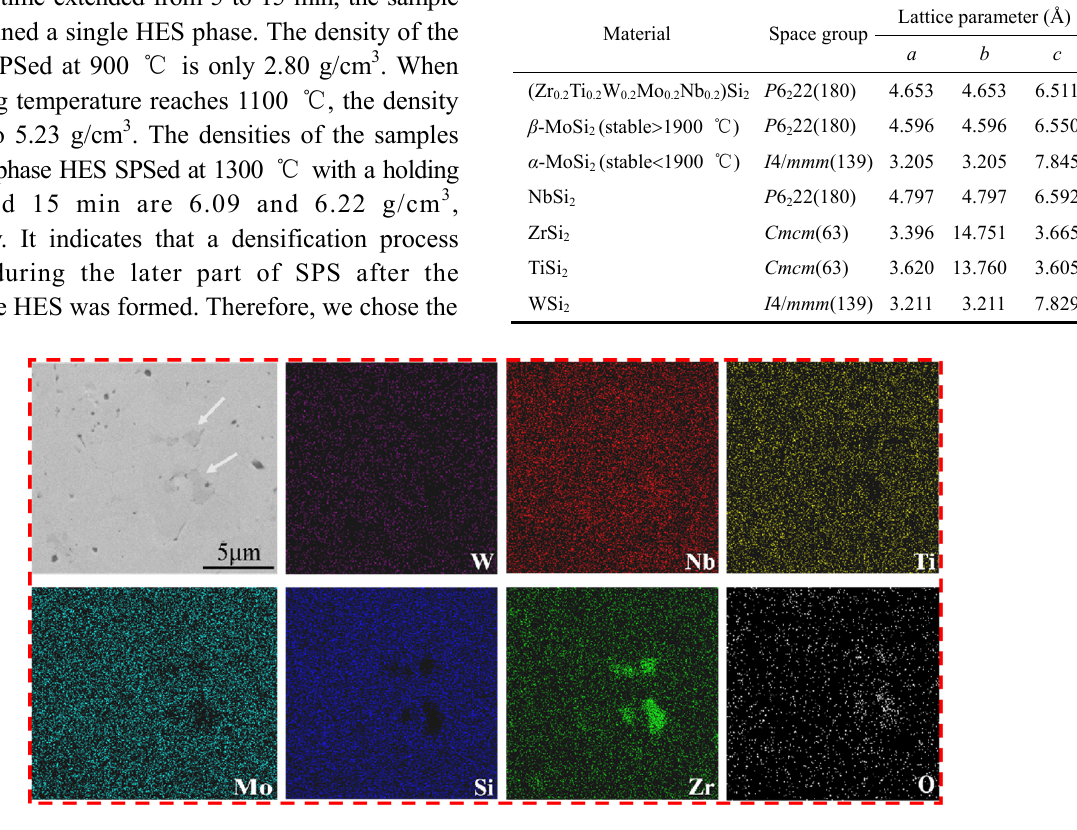
Fig. 2 SEM images of the polished surface of (Ti 0.2 Zr 0.2 Nb 0.2 Mo 0.2 W 0.2 )Si 2 SPSed at 1300 ℃ for 15 min, with the corresponding EDS mapping of Ti, Zr, Nb, Mo, W, and Si